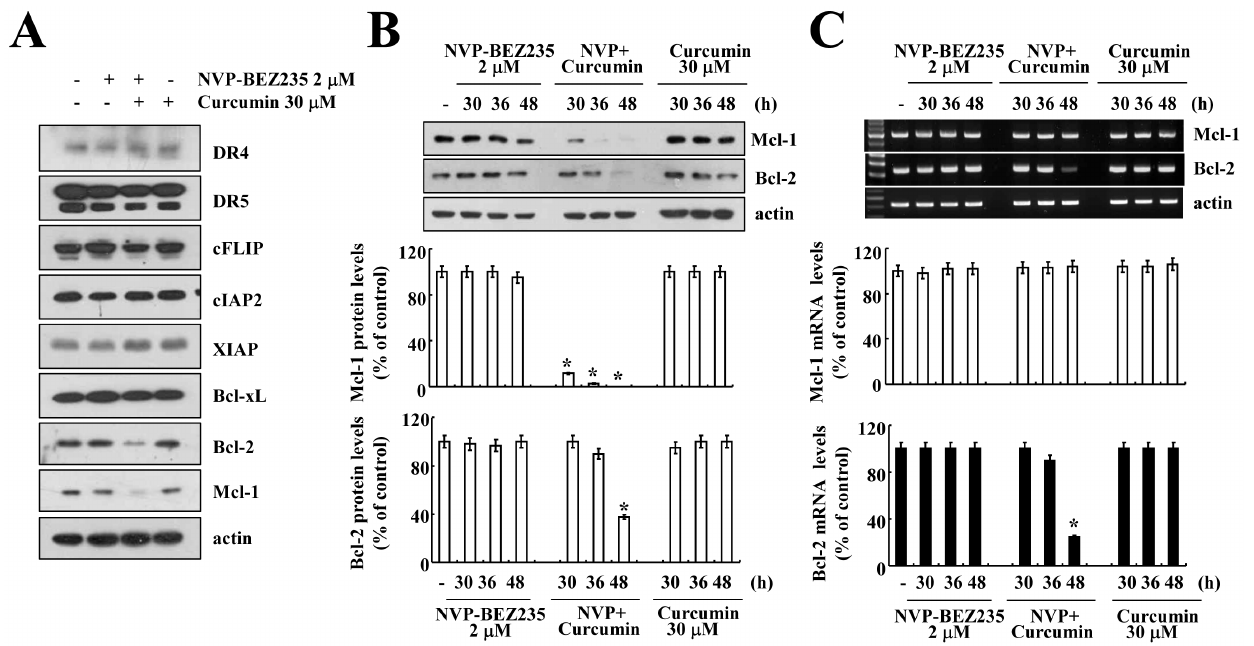
Figure 3. Effect of combined treatment with NVP-BEZ235 and curcumin on apoptosis-related proteins. (A) Caki cells were treated with 2 m M NVP-BEZ235 in the presence or absence of 30 m M curcumin for 48 h. Equal amounts of cell lysate (40 m g) were subjected to electrophoresis and analyzed by western blotting for DR4, DR5, cFLIP, cIAP2, XIAP, Bcl-xL, Bcl-2, and Mcl-1 and actin as a control for protein loading. (B and C) Caki cells were treated with 2 m M NVP-BEZ235 in the presence or absence of 30 m M curcumin for the indicated time periods. Equal amounts of cell lysate (40 m g) were subjected to electrophoresis and analyzed by western blotting for Mcl-1 and Bcl-2, as well as actin as a control for protein loading (B, upper panel). The Bcl-2 and Mcl-1 mRNA expression level was determined using RT-PCR (C, upper panel). The band intensities of Mcl-1 and Bcl-2 protein (B, upper panel) and mRNA (C, upper panel) were measured using the public domain JAVA image-processing program ImageJ (B and C, lower panel). The values in B and C represent the mean 6 SD from three independent samples. * p , 0.001 compared to NVP-BEZ235 alone and curcumin alone. The data represent three independent experiments.